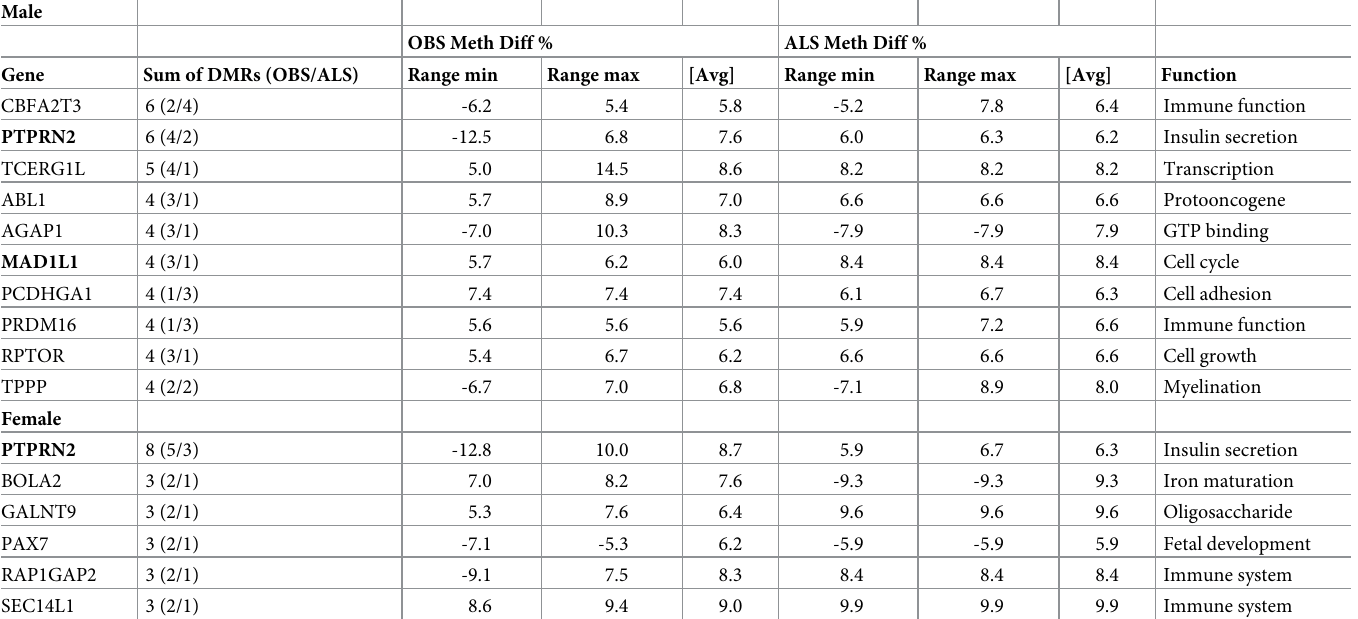
Table 2. Top 10 genes associated with differential methylation in neonates, common to the OBS and ALSPAC cohorts. In some instances, multiple DMRs were asso- ciated with a given gene therefore a range of methylation difference percentage is provided. Genes with at least three DMRs are shown. The genes in bold were common to both males and